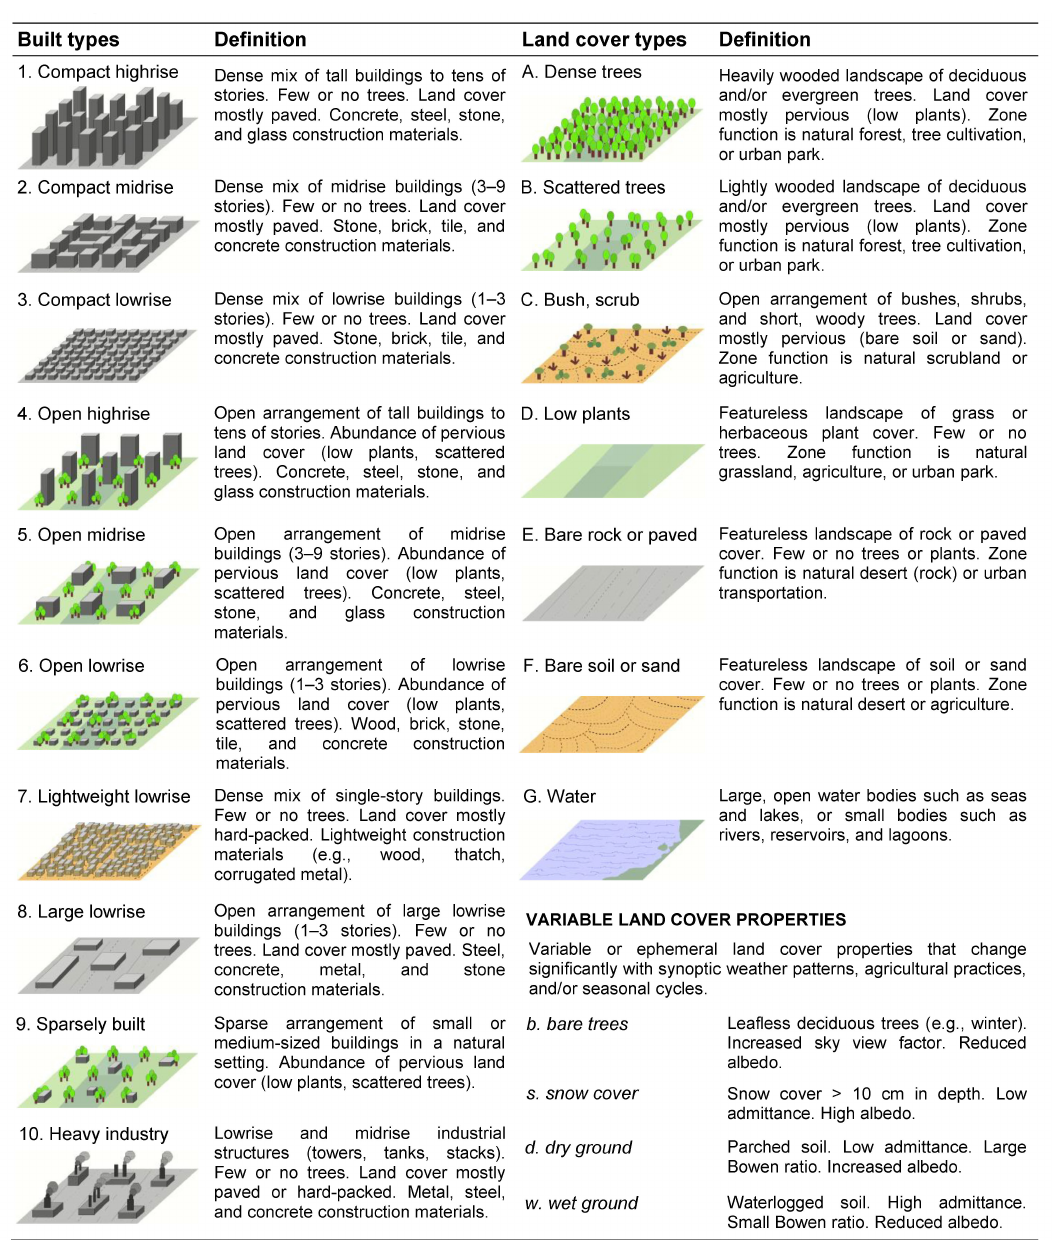
Figure 2. Abridged definitions for local climate zones [29]. ©American Meteorological Society. Used with